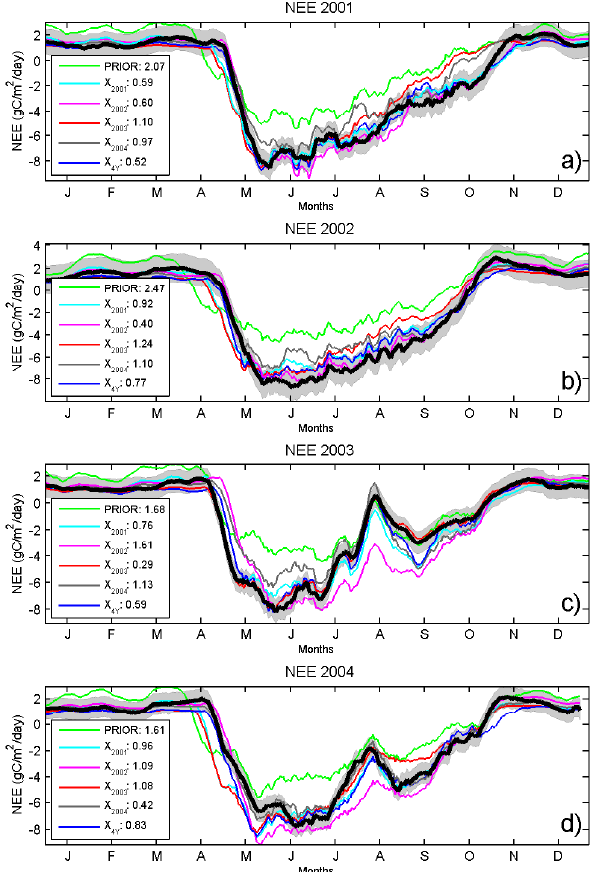
Figure 6. For 2001, 2002, 2003 and 2004, fits to the latent heat flux observations (thick black curve) of the model run with the standard and the optimized parameter sets. Figure legends show the model– data RMSE for the different parameter sets. Observation errors are represented by the grey shaded